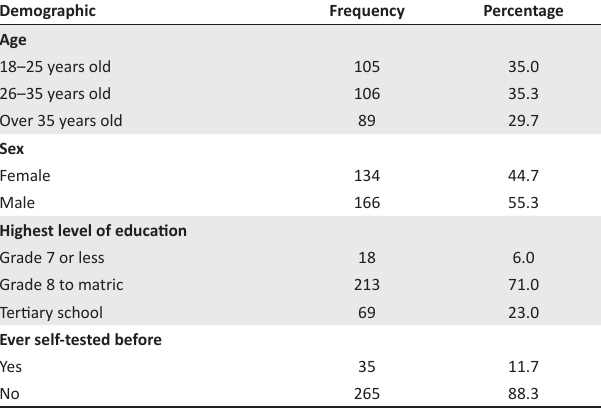
TABLE 1: Demographic characteristics. Sample size = 300. Demographic